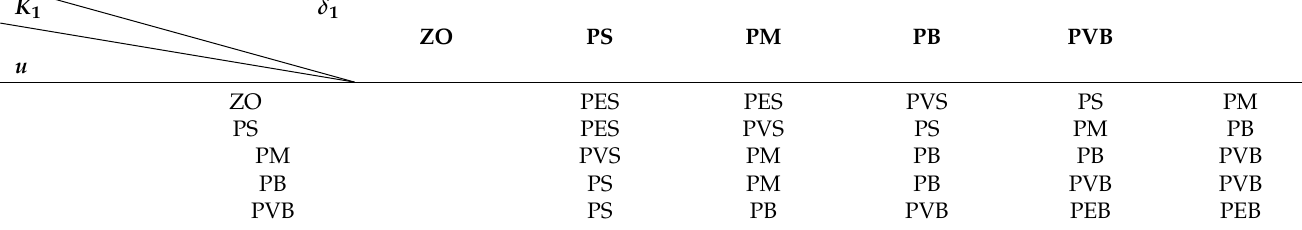
Table 2. The fuzzy control rules of K 1 .